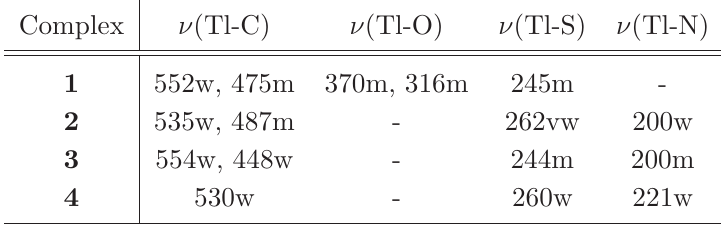
Table 8 Significant IR absorption bands (1800-1000 cm − 1 ) of the free ligands and